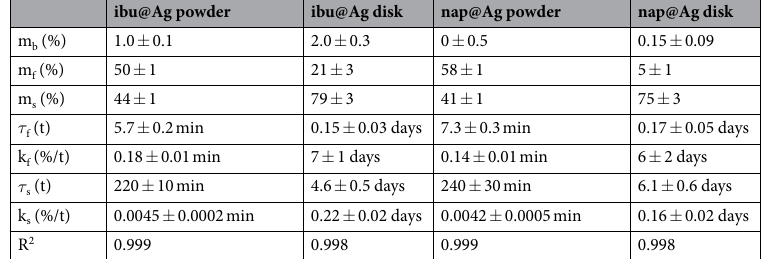
Table 2. The kinetic parameters of the release of ibuprofen and naproxen.